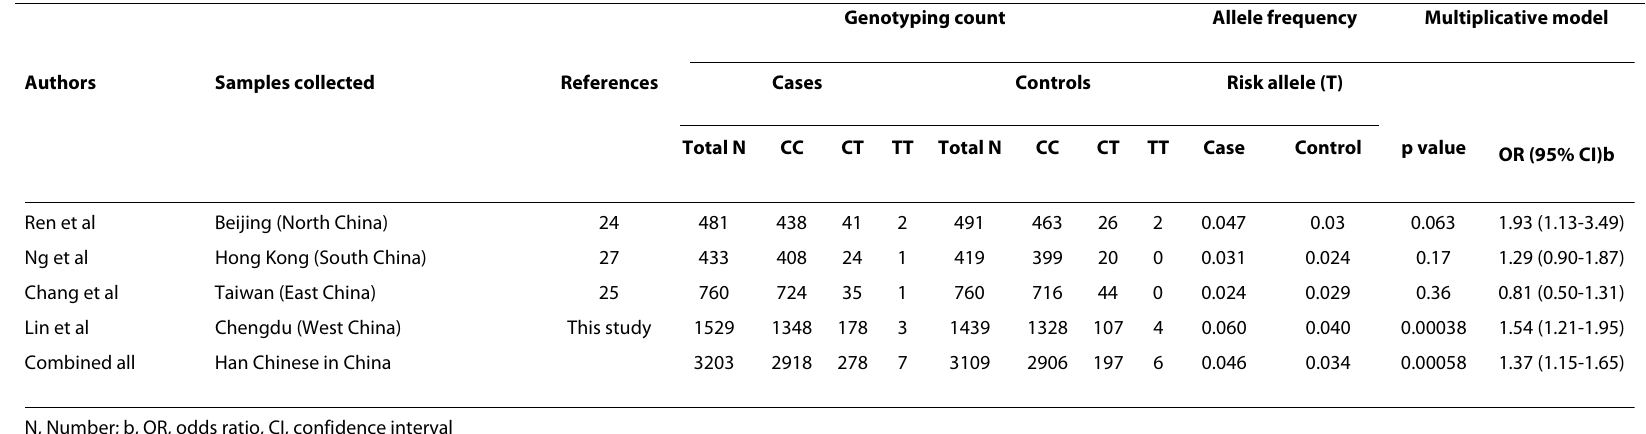
Table 2: Meta-analysis of rs7903146 in TCF7L2 with T2D in the Han Chinese populations